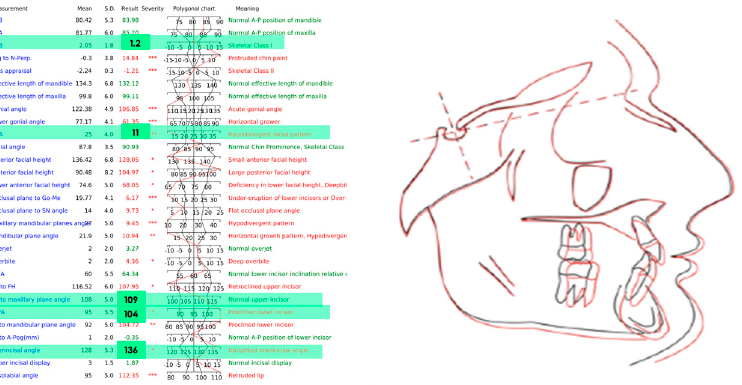
Figure 8. Post-treatment panoramic and lateral X-rays. The supernumerary lower tooth will be extracted following patient need in a second time. Cephalometric superimposition shows the torque correction and deep bite resolution.